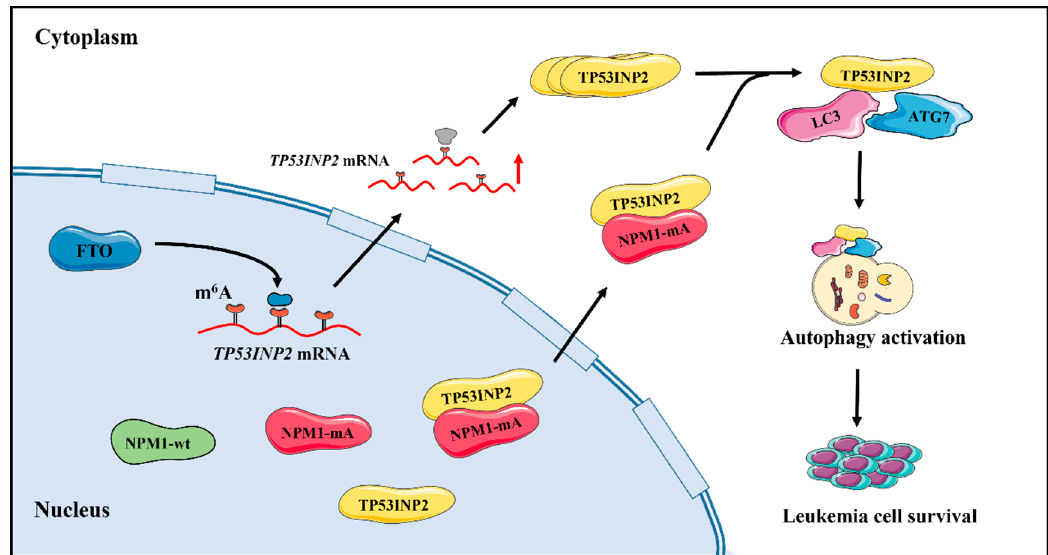
Figure 7. Schematic diagram describing the functional significance of cytoplasmic TP53INP2-mediated autophagy in NPM1 -mutated leukemia cells. TP53INP2 is upregulated by FTO-mediated m 6 A modification and delocalized into the cytoplasm by NPM1-mA. Cytoplasmic TP53INP2 enhances autophagy activity by facilitating the interaction of LC3-ATG7 and further promotes the survival of leukemia cells.